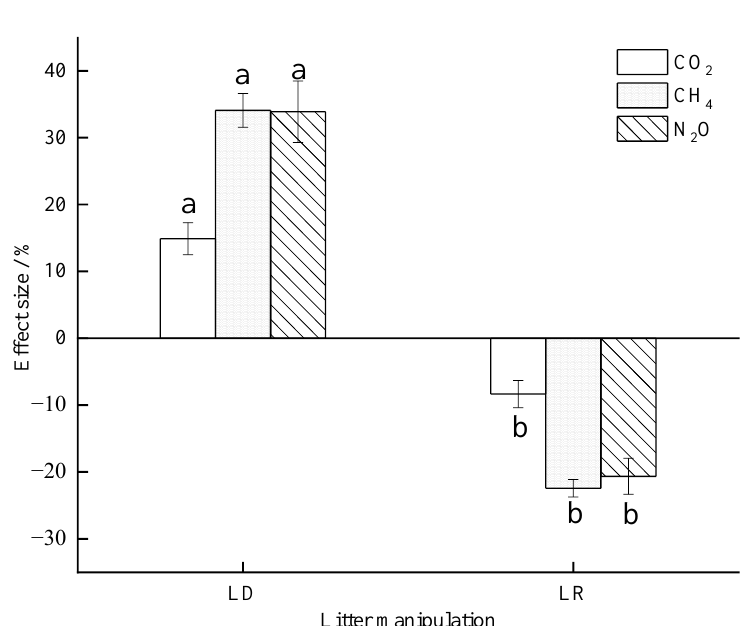
Figure A1. Effect size of litter manipulation on the soil GHG fluxes during the study period. The effect size is the variation rate of the soil GHG fluxes in the LD and LR treatments, compared with the CK treatment. Lowercase letters represent significant differences in the effect size between the LD and the LR treatments for each individual gas. Litter manipulation treatment abbreviations: CK, unchanged litter input; LD, doubled litter; LR, litter removal. Table A1. Effect of litter manipulation, sampling date and their interactions on soil GHG fluxes, soil temperature (ST), soil water content (SWC), soil inorganic nitrogen, and soil microbial biomass